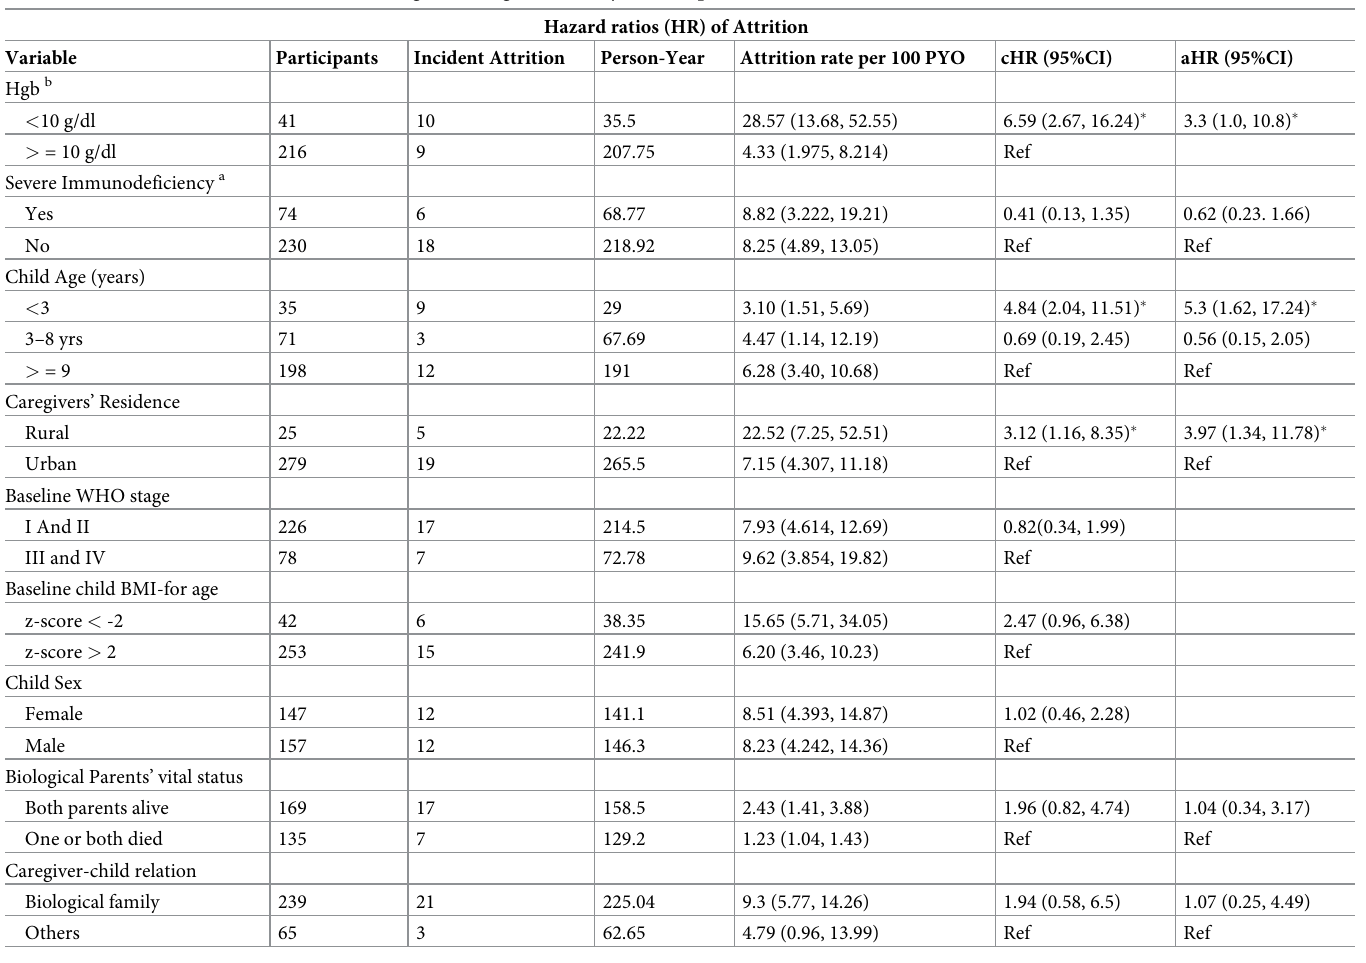
Table 2. Hazard ratios (HR) of attrition according to Cox regression analyses, Ethiopia, 2017.